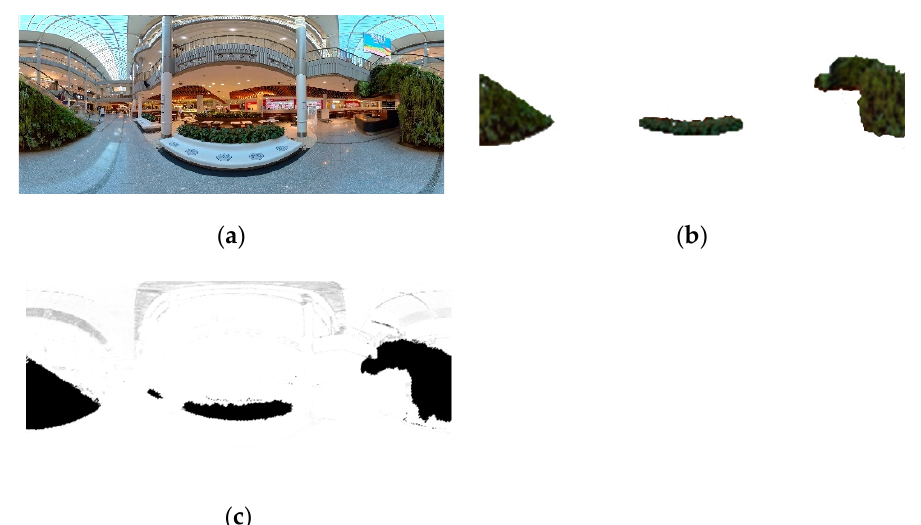
Figure 3. The results of greenery extraction. ( a ) the original 360° panoramic image, ( b ) automated